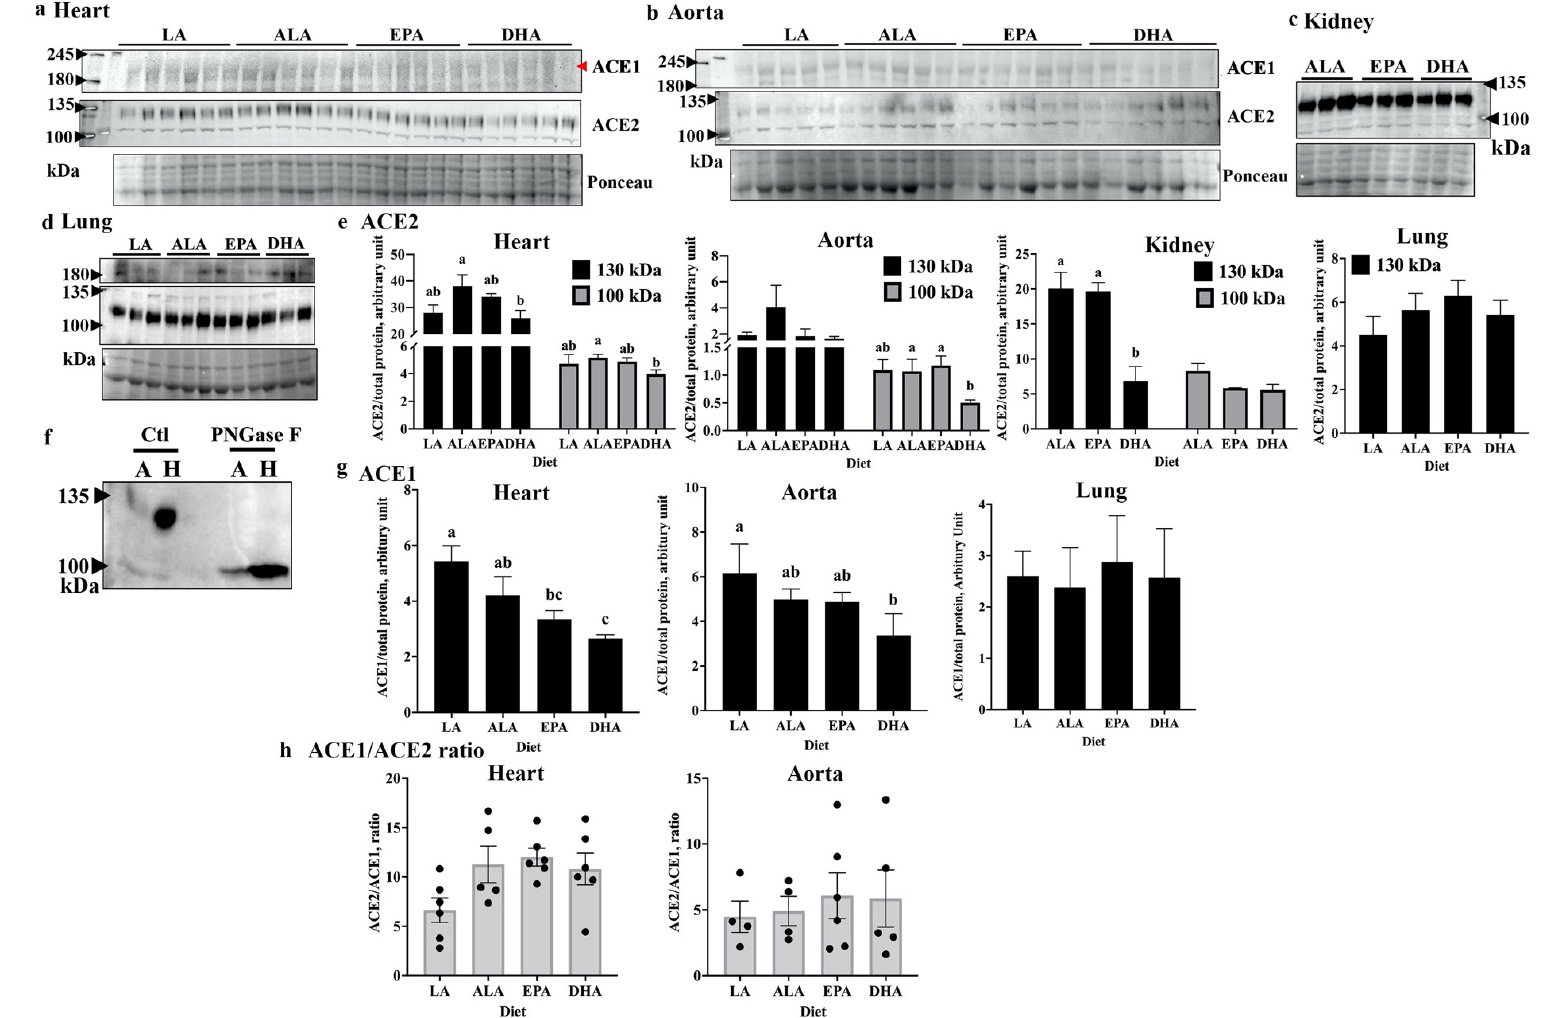
Figure 1. DHA reduces both ACE1 and ACE2 levels in key rat tissues. Western blotting was used to measure ACE1 and ACE2 levels relative to total protein load,